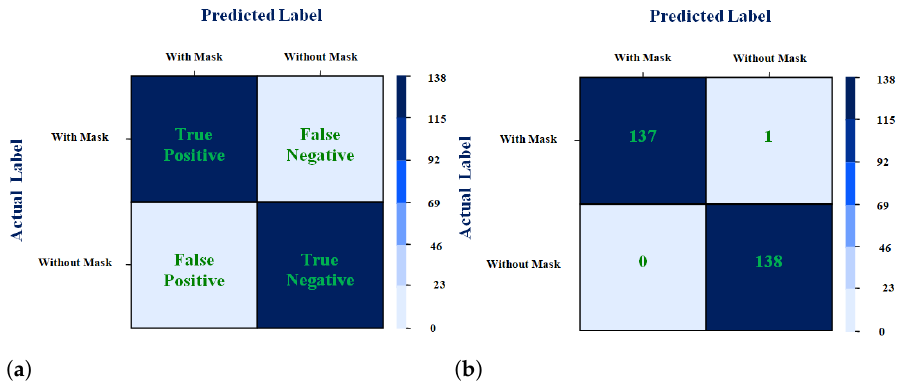
Figure 9. ( a ) Confusion matrix of standard form, ( b ) Confusion matrix of CMNV2 proposed